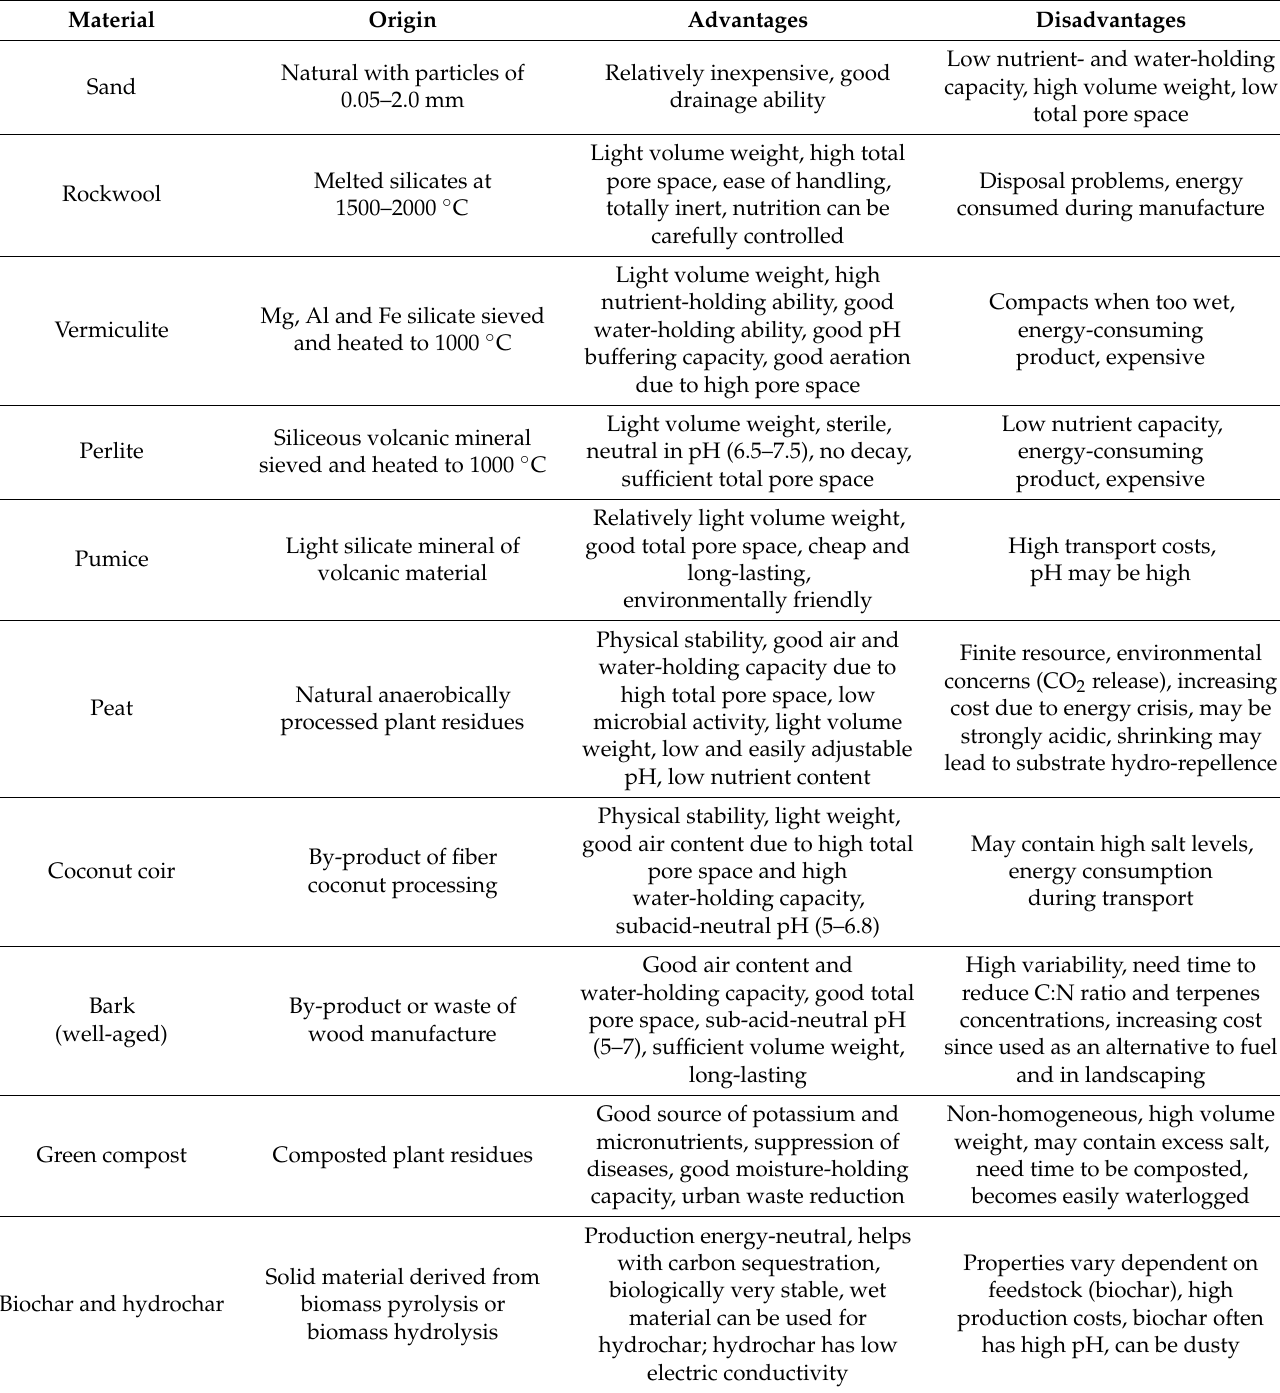
Table A4. Comparison of different substrates/GM modified after Savvas and Gruda